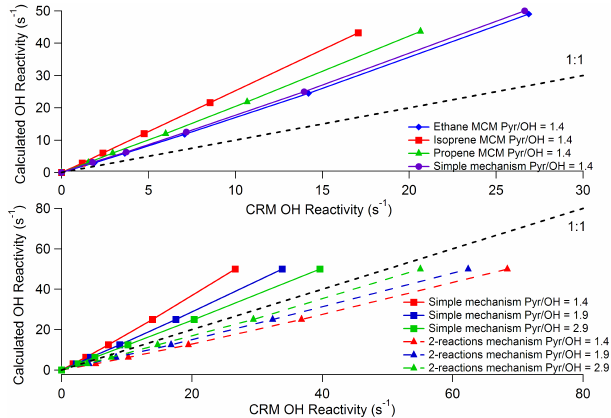
Figure 8. Simulations of the artifact due to not operating the in- strument under pseudo-first-order conditions. Comparison of OH reactivity values calculated from the addition of gas standards to simulated values (simulation of the C1–C2–C3 modulations; see text). Top panel: addition of four different gas standards (isoprene: red squares; ethane: blue diamonds; propene: green triangles; and a surrogate standard for the simple mechanism: purple circles) at a pyrrole-to-OH ratio of 1.4. Simulations were conducted using the MCM and the simple mechanism as indicated in the legend. Bottom panel: addition of a unique standard at three different pyrrole-to-OH ratios (1.4: red symbols; 1.9: blue symbols; and 2.9: green symbols) for simulations conducted with the simple mechanism (squares) and the two-reaction mechanism (triangles). The gas standard added in the model for these two mechanisms has a reaction rate constant toward OH of 5.0 × 10 − 12 cm 3 molecules − 1 s − 1